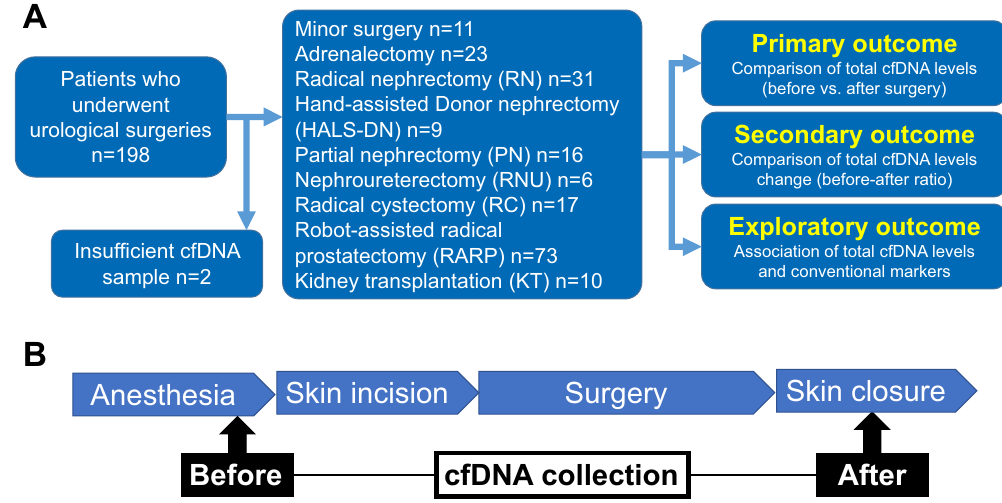
Figure 1. Outline of this study. Outlines of the entire study ( A ) and blood sampling methods ( B